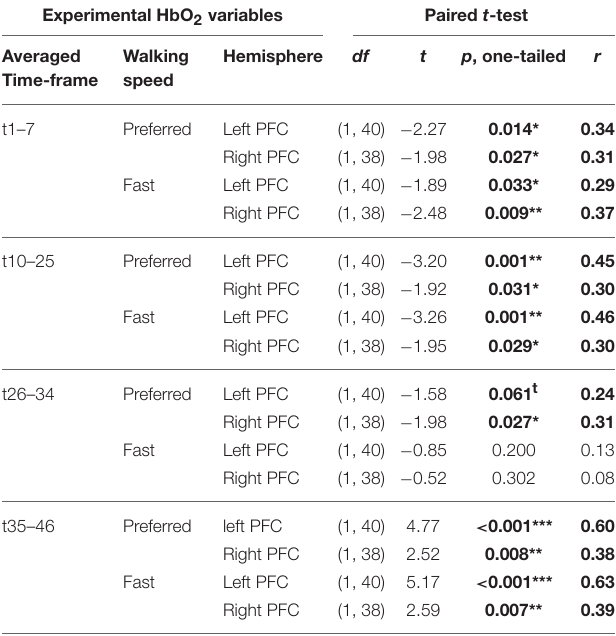
TABLE 6 | Results of paired t-test for baseline vs. experimental PFC activity at pre-test. Experimental HbO 2 variables Paired t -test Averaged Walking Time-frame